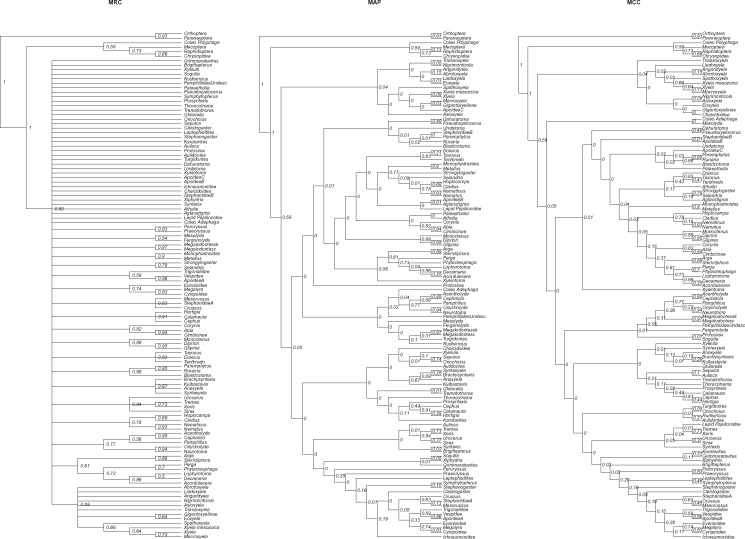
MRC, MAP, and MCC consensus trees for Hymenoptera constructed from a posterior sample of trees obtained when only morphological data was analyzed. The trees are presented as cladograms with arbitrary branch lengths as summary of the posterior distribution of branch lengths results in numerous branches with negative length for the maximum clade credibility tree. The posterior probability of each clade is presented as a node label. In the MCC and MAP trees many clades express very low support and most are not consistent with molecular phylogenies or conventional understanding of Hymenopteran evolution. For the MRC tree few clades can be presented with support \documentclass[12pt]{minimal}
\usepackage{amsmath}
\usepackage{wasysym}
\usepackage{amsfonts}
\usepackage{amssymb}
\usepackage{amsbsy}
\usepackage{upgreek}
\usepackage{mathrsfs}
\setlength{\oddsidemargin}{-69pt}
\begin{document}
}{}$>$\end{document}0.5, but those that are present are broadly congruent with established Hymenopteran phylogenetic relationships. Posterior probabilities of 0 are induced by the rounding of values to 2 decimal places.